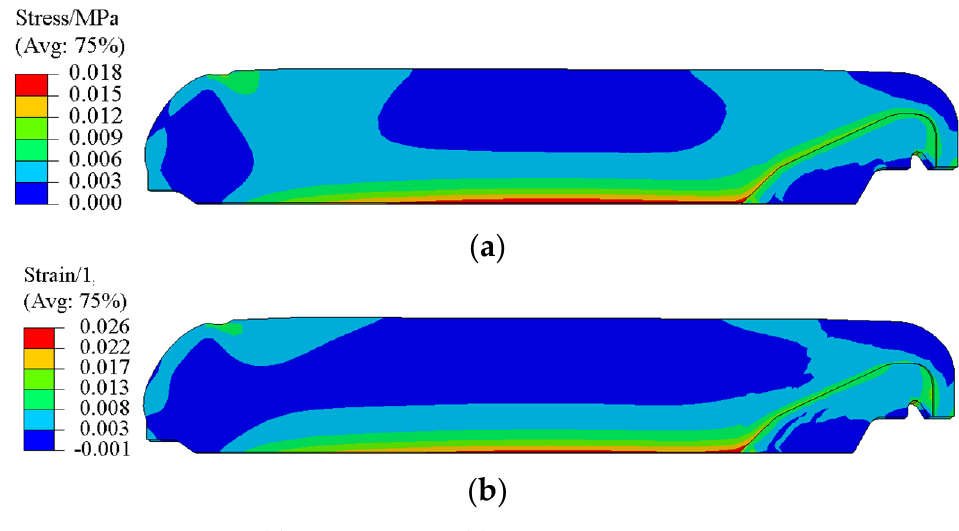
σ . ( b ) Contours of tot ε . Figure 9. ( a ) Contours of σ tot c . ( b ) Contours of ε tot c . c c and ε tot in the propellant grain at the end of c c